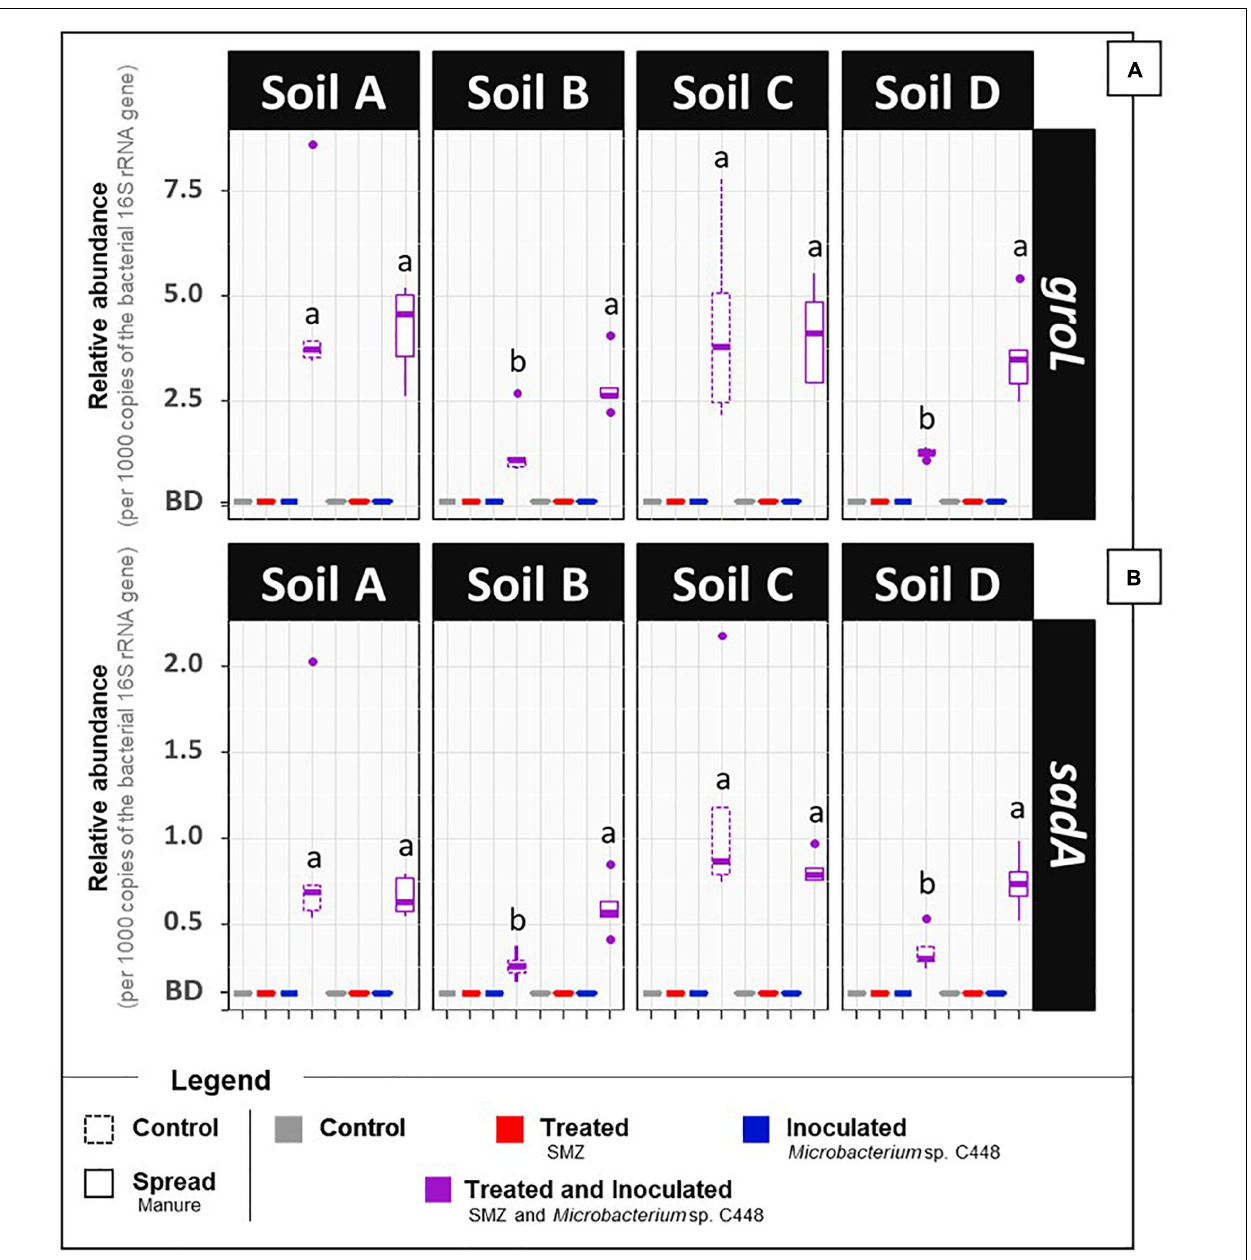
FIGURE 1 | Relative abundances of groL (A) and sadA (B) gene sequences in the soil microcosms (four types of soil, A, B, C, and D, amended or not with manure, treated or not with SMZ, and inoculated or not with Microbacterium sp. C448). After 1 month of incubation, gene sequence abundances were measured by quantitative PCR and expressed per 1000 copies of the bacterial 16S rRNA gene rss (Tukey’s test, n = 5, p < 0.05). BD: below the detection limit (0.1 copy per 1,000 16S rRNA gene).